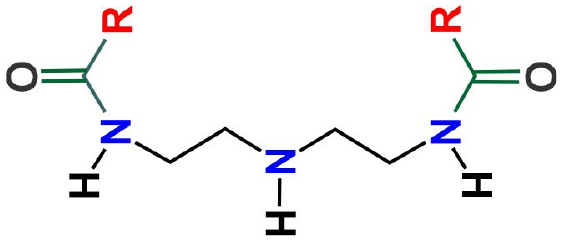
Figure 6. Chemical structure of the dialkyl-diamide of coffee bagasse oil (R = alkyl chains). It has been reported that the inhibitors with two hydrophobic chains show higher inhibition efficiencies than those observed with the inhibitors of one and three hydrophobic chains [13]. In addition, the high content of hydrocarbon chains with unsaturations ( ≈ 57%) and short hydrocarbon chains ( ≈ 36%) could favor the phase angles observed in both time constants, and their adsorption mode could occur as suggested in Figure 7.